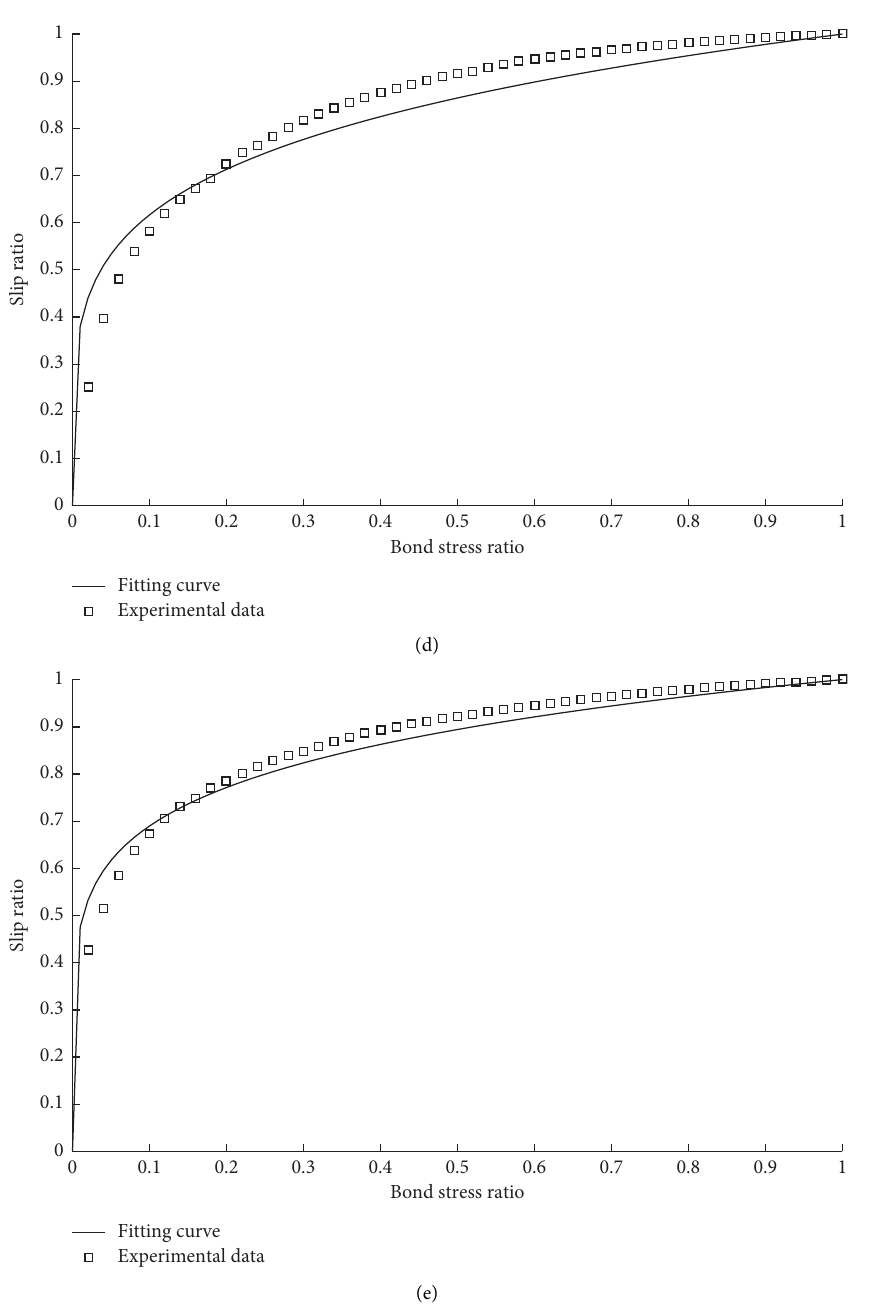
Figure 9: Relationship between stress ratio and slip ratio of different SAP contents. (a) 0; (b) 0.1%; (c) 0.2%; (d) 0.3%; (e)